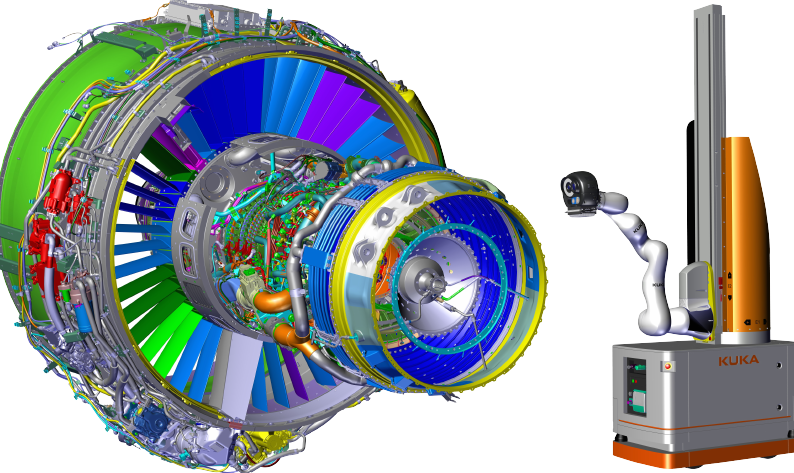
Figure 1. The robot-based inspection platform and an aircraft engine to be